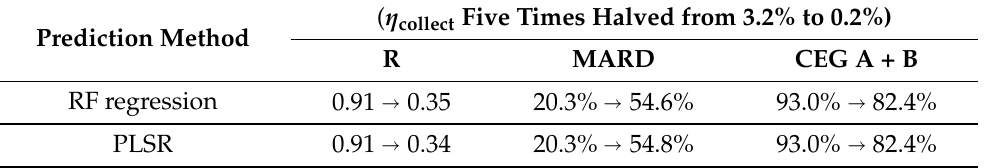
Table 3. Prediction evaluation results of the three criteria. R: regression analysis, MARD: mean absolute relative difference and CEG A + B: zones A and B in the Clarke error grid according to the results of [84]. Prediction